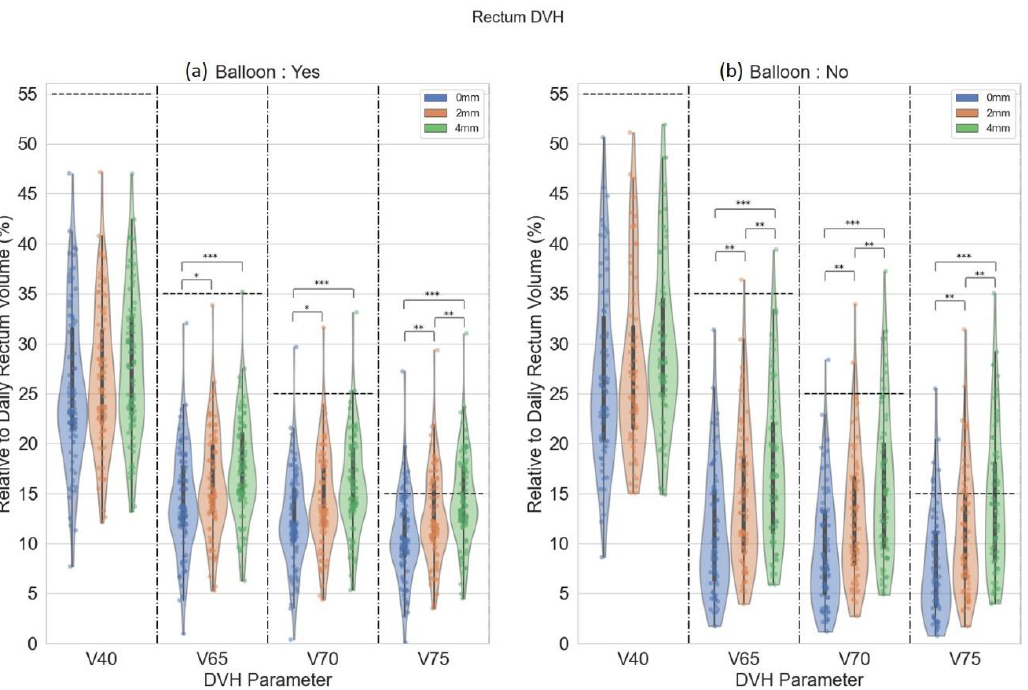
Figure 4. Violin plot for rectum DVH parameters for patients with (a) and without (b) an endorectal balloon. The parallel dash lines indicate the dose constraints. The annotation ‘*’ denotes statistical significance with p ≤ 0.05, ‘**’ denotes p ≤ 0.01, and ‘***’ denotes p ≤ 0.001.